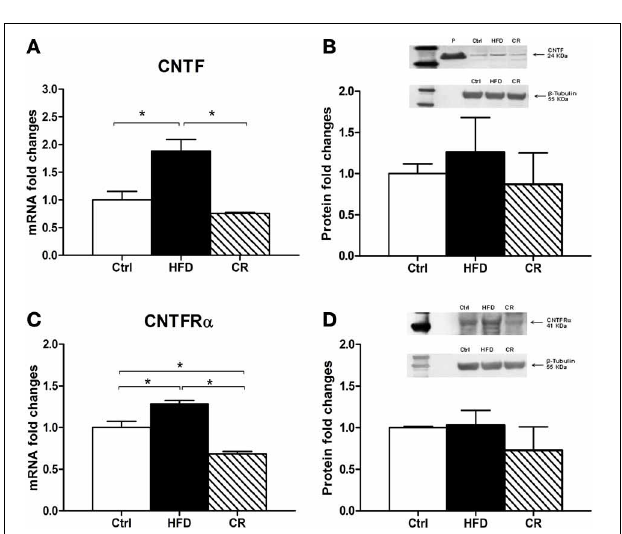
FIGURE 2 | RT-PCR (A and C) and Western blot (B and D) analyses of CNTF (A and B) and CNTFR α (C and D) expression in the hypothalamus of HFD, control (Ctrl) and CR mice. For Western blots the densitometric analysis was normalized to β -tubulin expression. In (B) recombinant CNTF (P, 30ng) loaded together with hypothalamic protein extracts served as a positive control. Mean ± SEM. ∗ P < 0 .